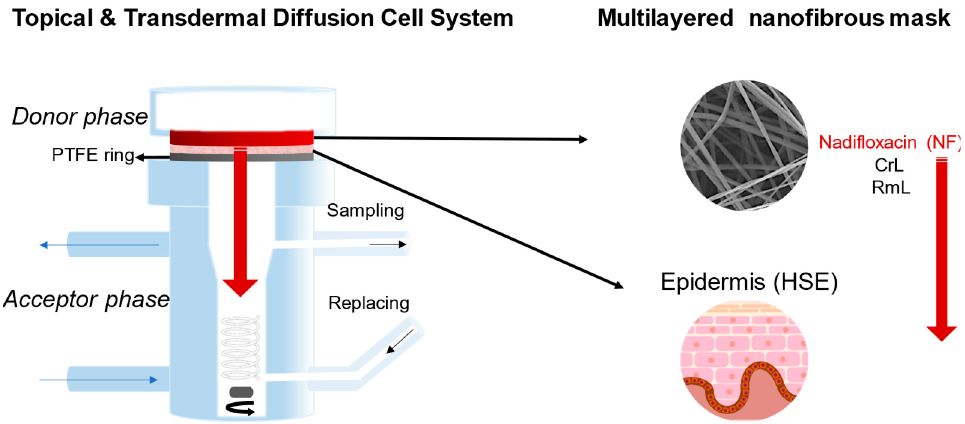
Figure 9. Experimental set up of skin permeability test of nanofibrous mask (multilayered mask containing nadifloxacin, CrL and RmL enzymes) using a topical and transdermal diffusion cell.